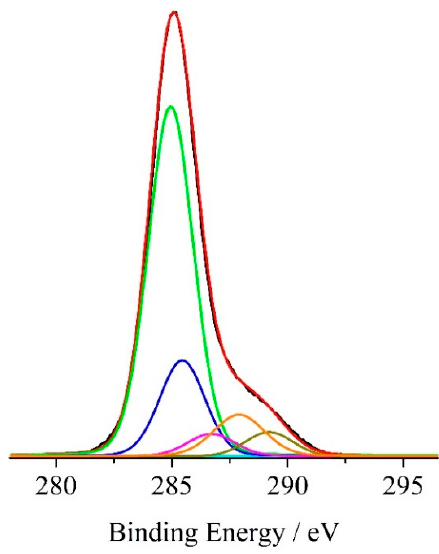
Figure 5. Al-K α excited XPS of the Au NPs–porphyrin system in the C 1s binding energy region. The green, blue, magenta, orange, and dark yellow lines refer to the 285.0, 285.5, 286.7, 287.9, and 288.9 eV components; the cyan line refers to the background and the red line superimposed on the experimental black profile refers to the sum of all Gaussian components.